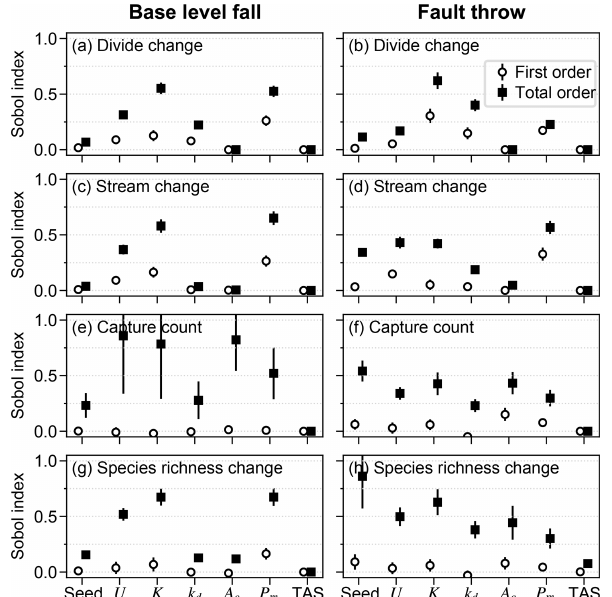
Figure 6. First- and total-order Sobol indices of drainage reorgan- isation responses. The factors are along the x axis for each of the responses (a–h) ; “seed” refers to the initial elevation seed.